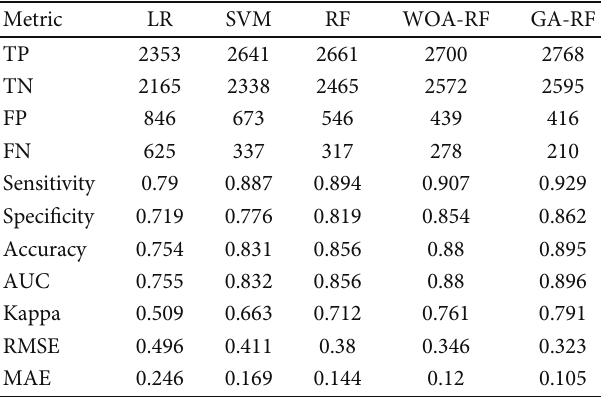
Table 7: Model performance on the training